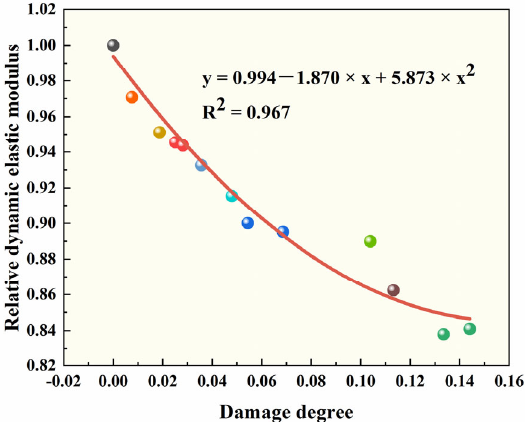
Figure 8. Fitting analysis of relative dynamic elastic modulus and damage degree.